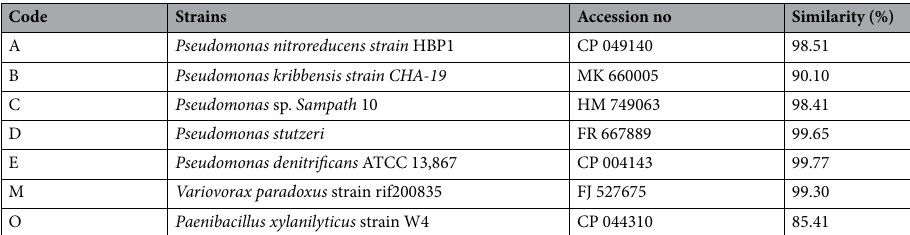
Table 5. The molecular identification of the isolated phosphate solubilizing bacteria in soils supplemented with phosphorus and lime, soils rich in phosphorus and control soils collected at Ukulinga farm, KwaZulu-